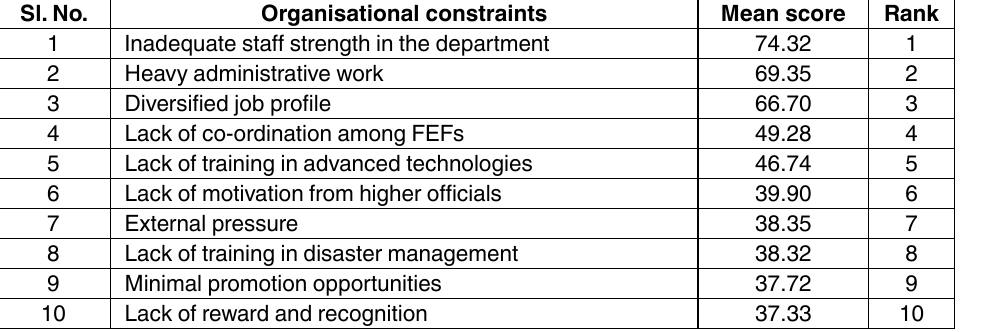
table 2. Organisational constraints as perceived by the FEFs of DDD, Kerala sl.